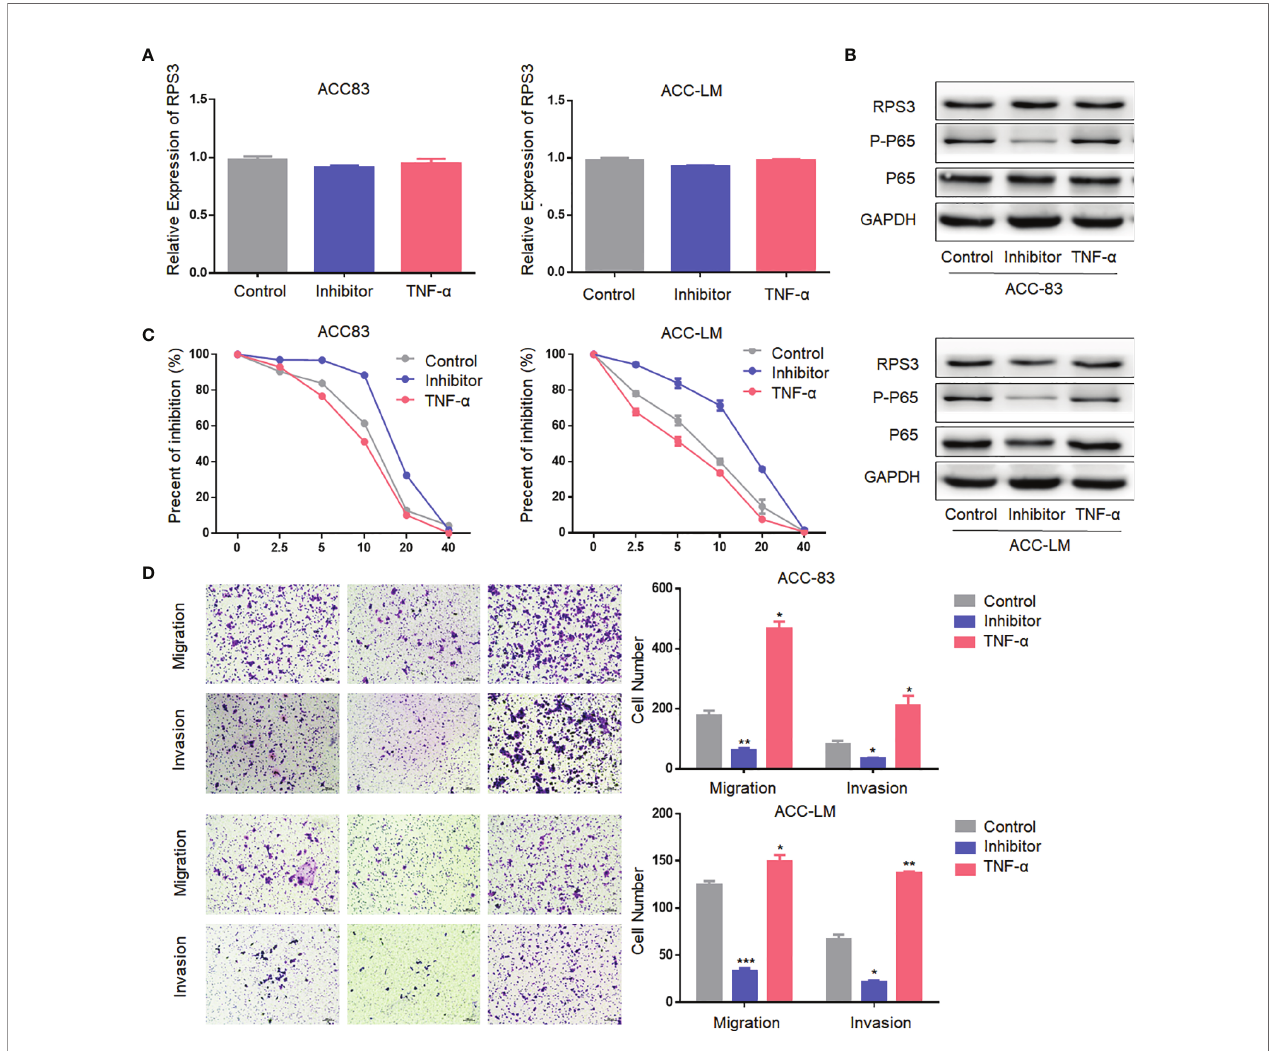
FIGURE 6 | The NF-kB signaling pathway regulate the cisplatin resistance and migration-invasion behavior of ACC cells. (A) The use of activators and inhibitors did not alter RPS3 mRNA expression levels. (B) The use of activators and inhibitors did not alter RPS3 protein expression levels, but alter the activation of NF- k B signaling pathway. (C) Cisplatin resistance decreased in ACC cells after inhibition of the NF-kB pathway, while activation of the NF-kB pathway promoted cisplatin resistance. (D) Migration and invasion decreased in ACC cells after inhibition of the NF-kB pathway, while activators promoted migration and invasion. *P < 0.05; **P < 0.01; ***P <